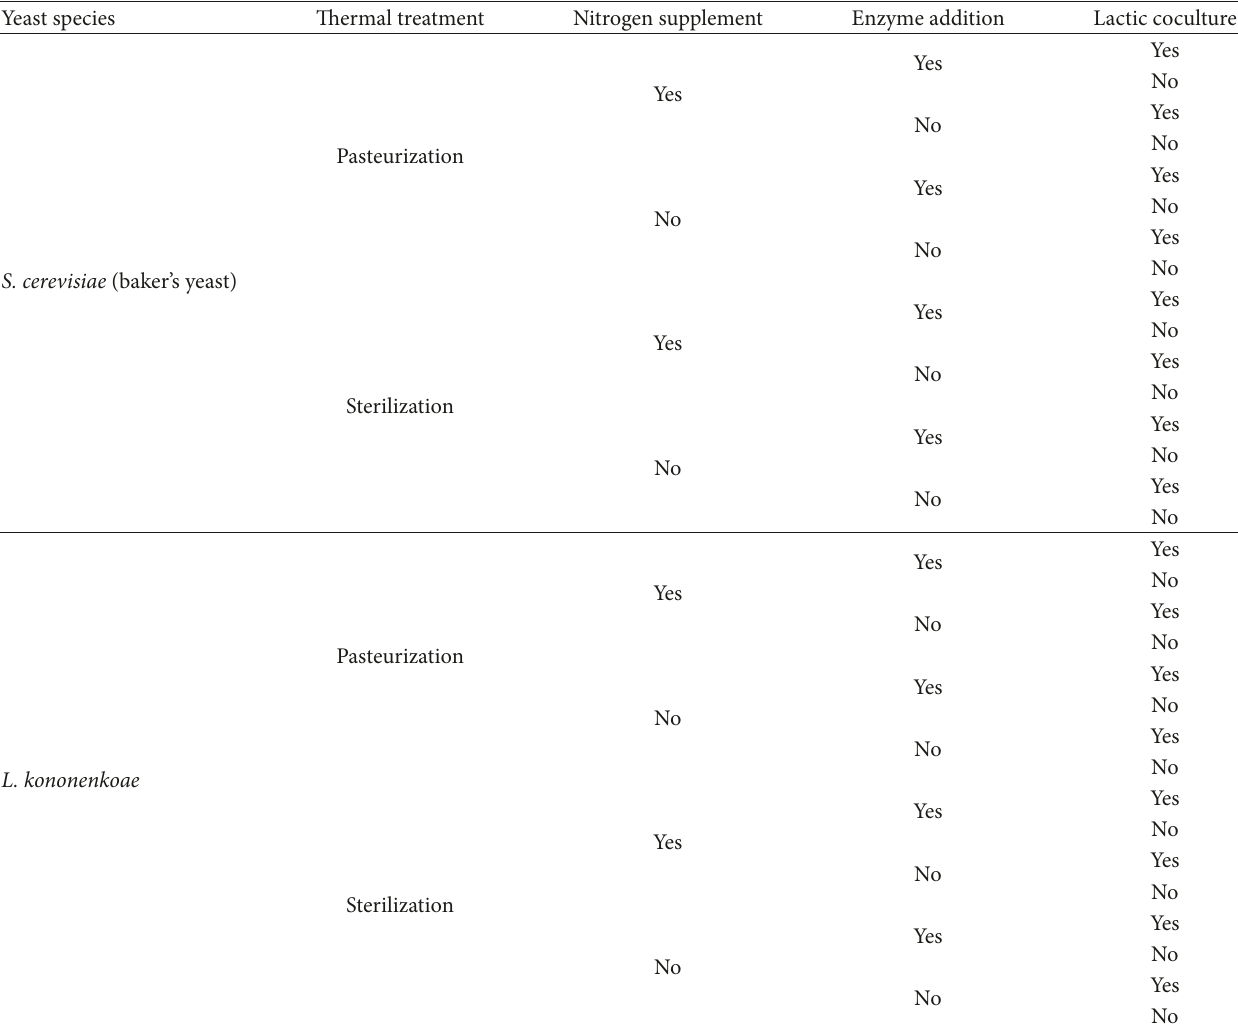
Table 1: Experimental